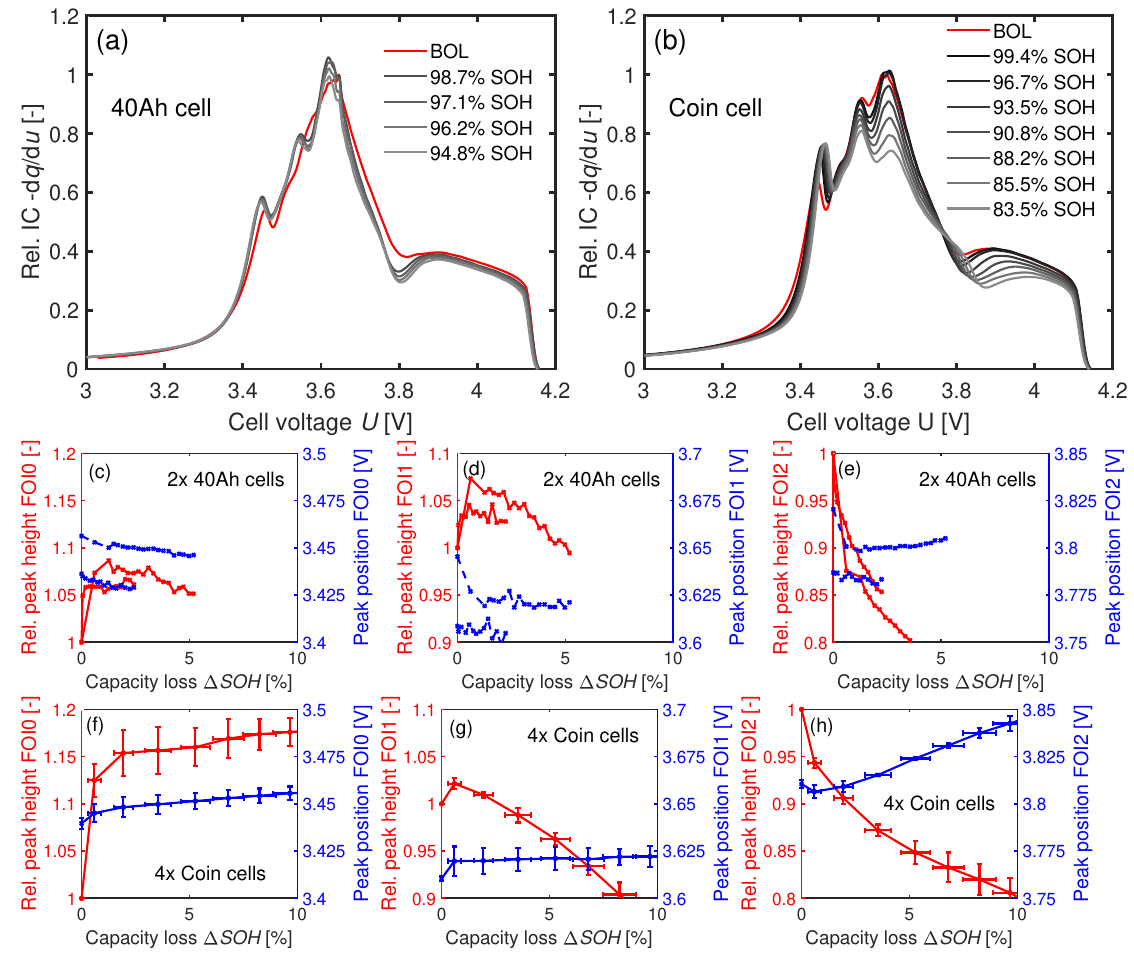
Figure 10. IC analysis of the 40Ah cells in ( a , c , d , e ) and of the coin cells in ( b , f , g , h ) at T = 25 ◦ C. ( a , b ) IC curves scaled to the respective maximum peak heights of FOI1 at BOL. c – h : Development of the FOIs depending on the loss of capacity ∆ SOH